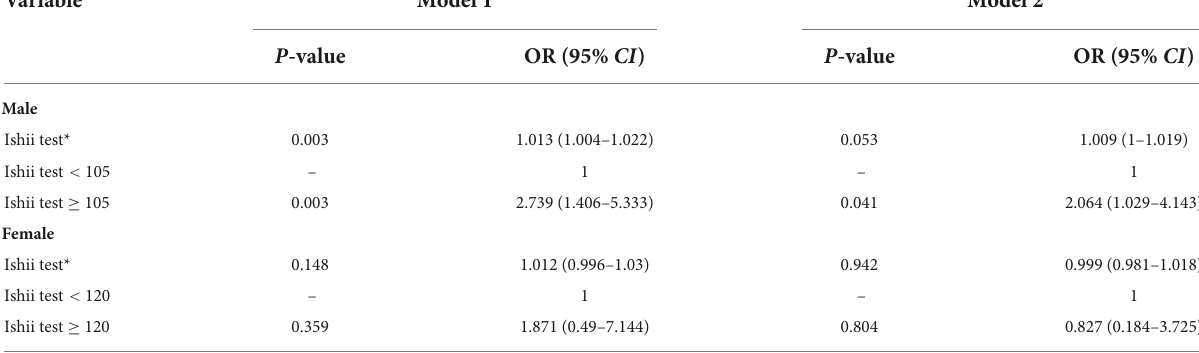
TABLE 3 Association between Ishii test scores and